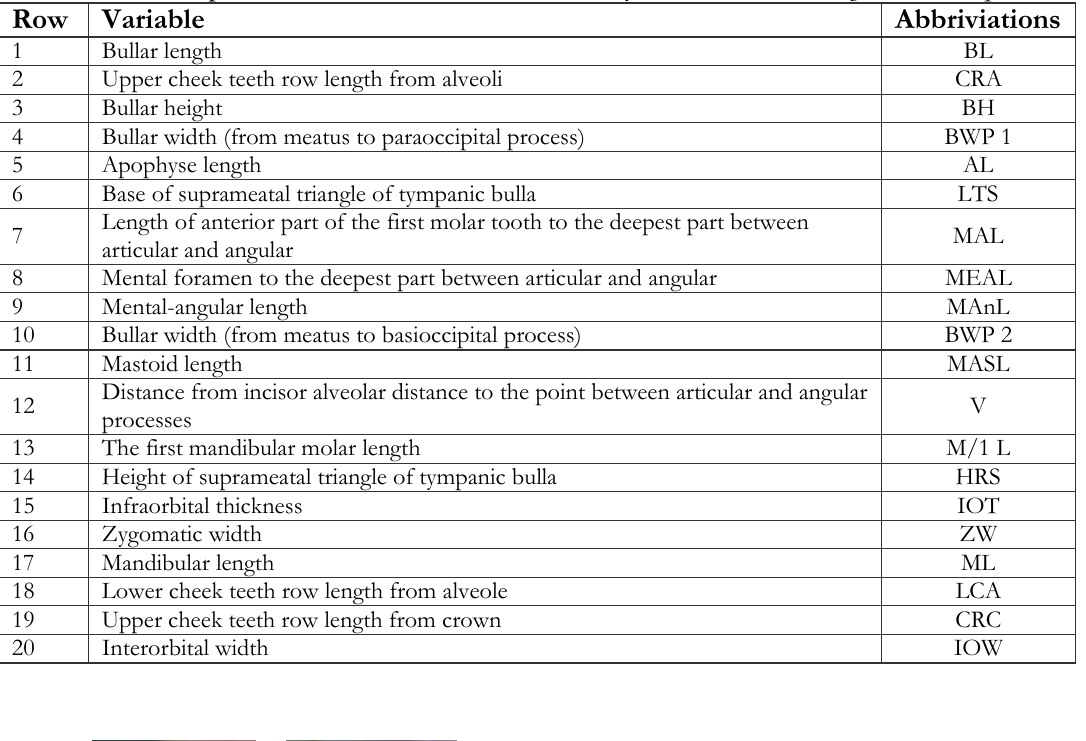
T ABLE 1 .- description of measured cranial and dentary characters in M. libycus and M. persicus